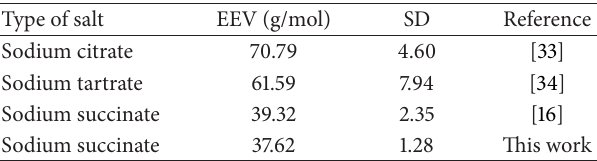
Table 4: EEV values (2) of PEG 6000 + sodium succinate + water at 298.15 K.